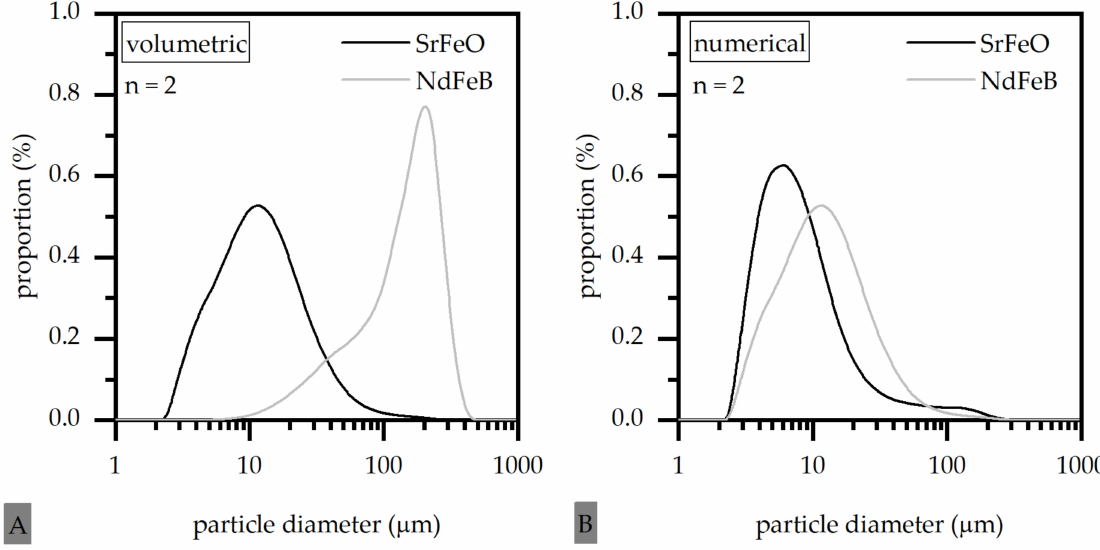
Figure 3. Mean particle size distribution comparison between anisotropic SrFeO and NdFeB based on volumetric ( A ) and numerical ( B )